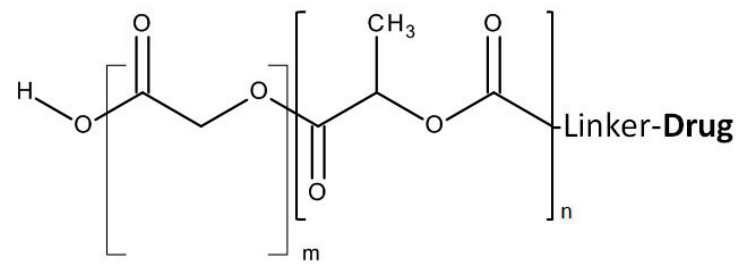
Figure 6. Structure of PLGA and its drug